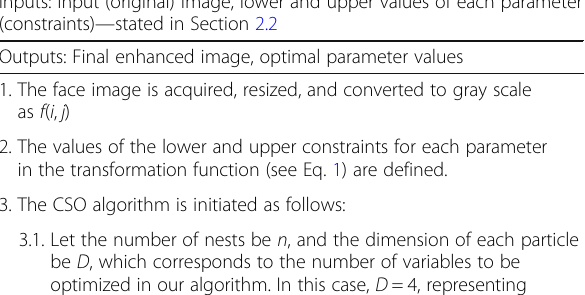
Table 1 Steps involved in the Proposed Face Image Enhancement